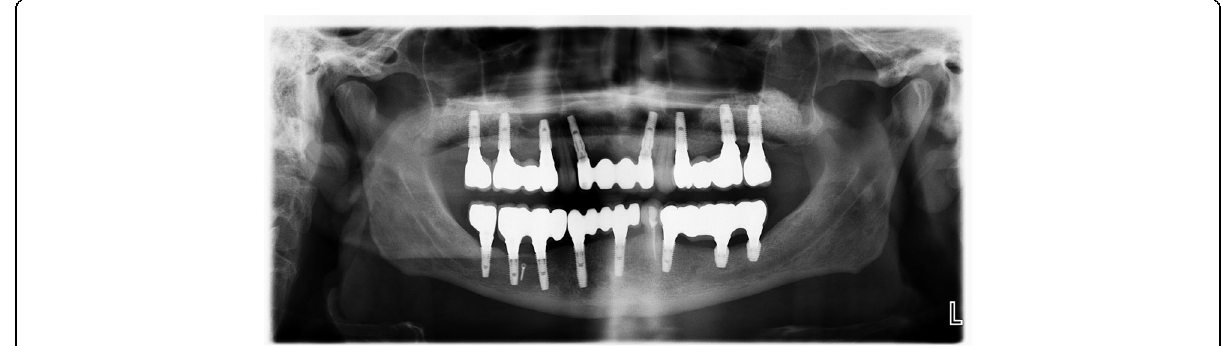
Fig. 12 A panoramic radiography after the delivery of the final